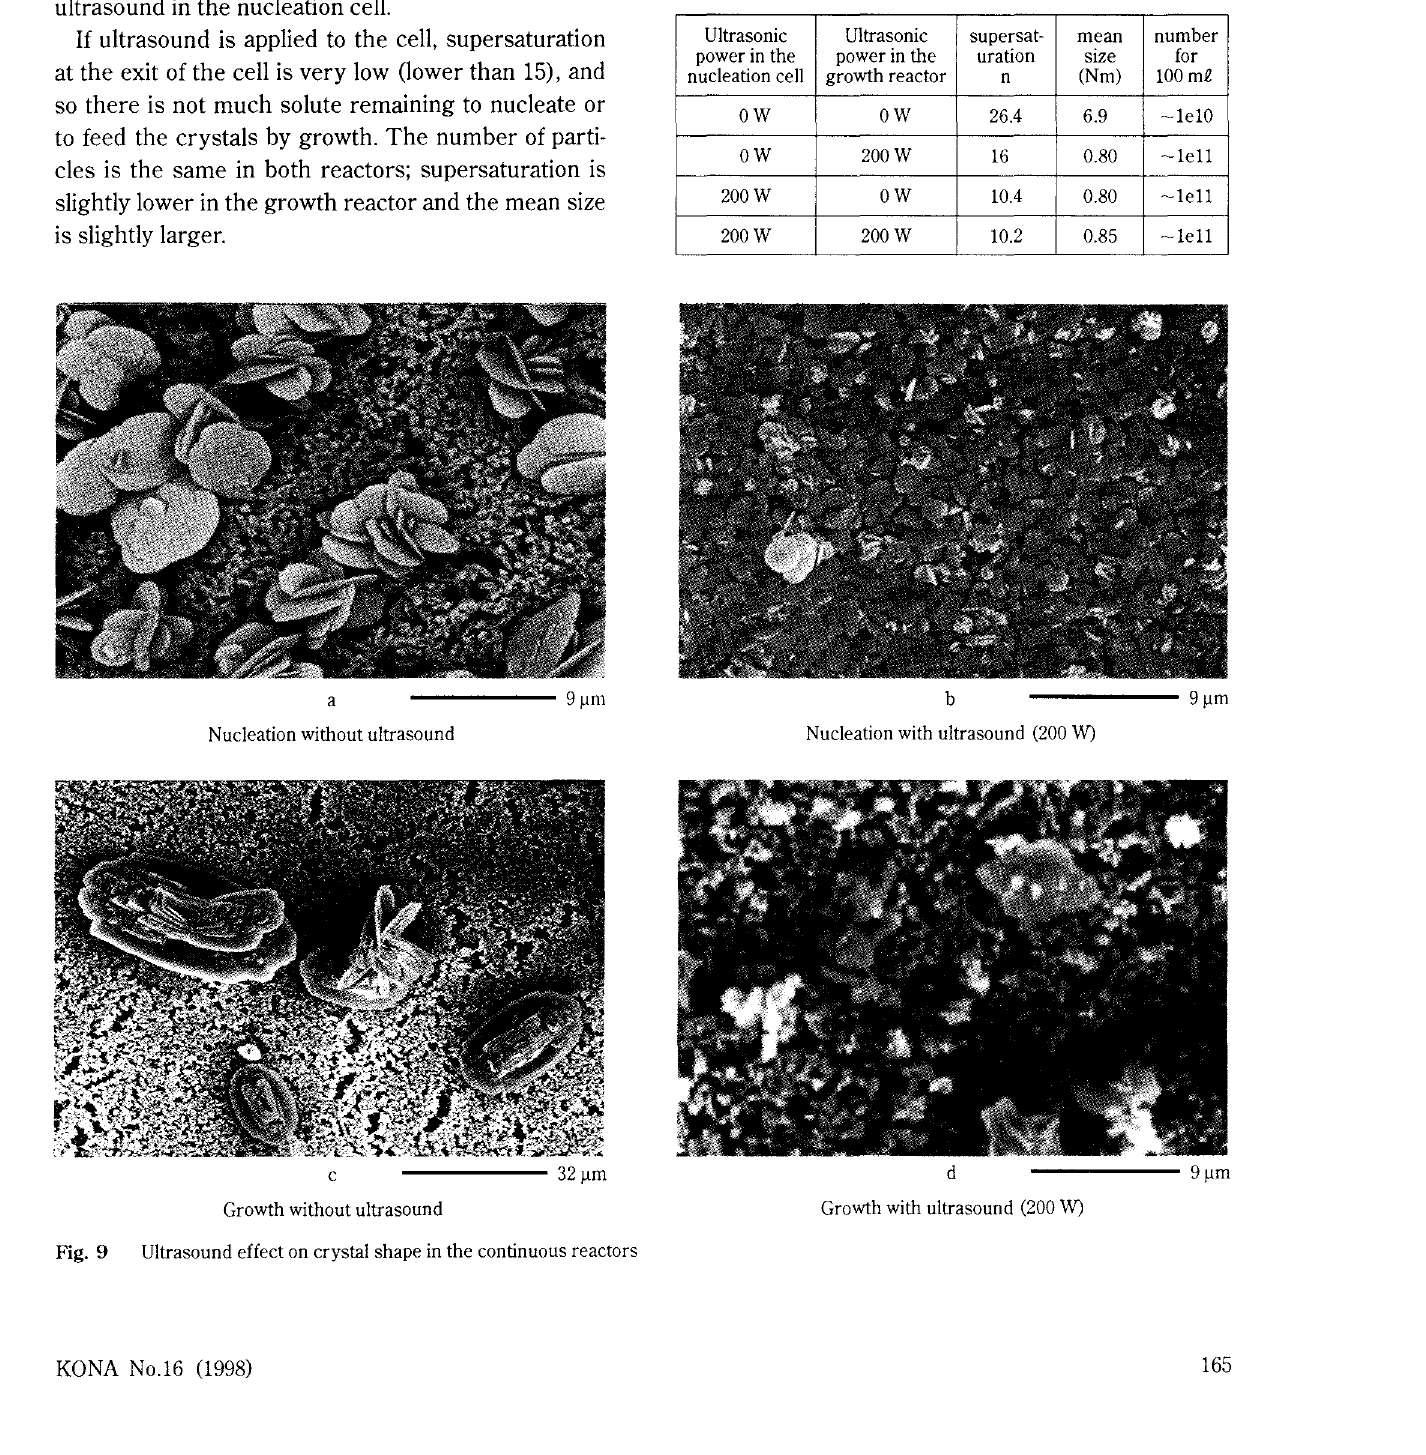
Ultrasound effect on crystal shape in the continuous reactors